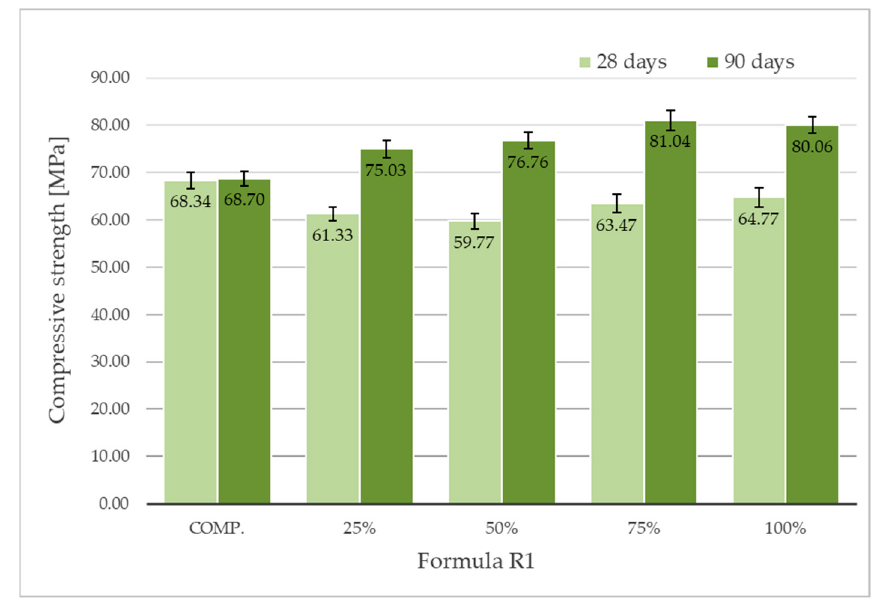
Figure 7. Compressive strength of formula R1 with 25%, 50%, 75%, and 100% of mixing water replaced with waste sludge water from the CP.